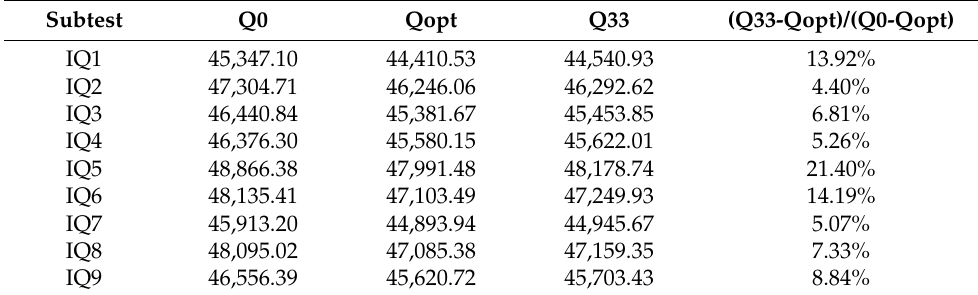
Table 4. Comparison of the BIC values for the IQ1–Q9